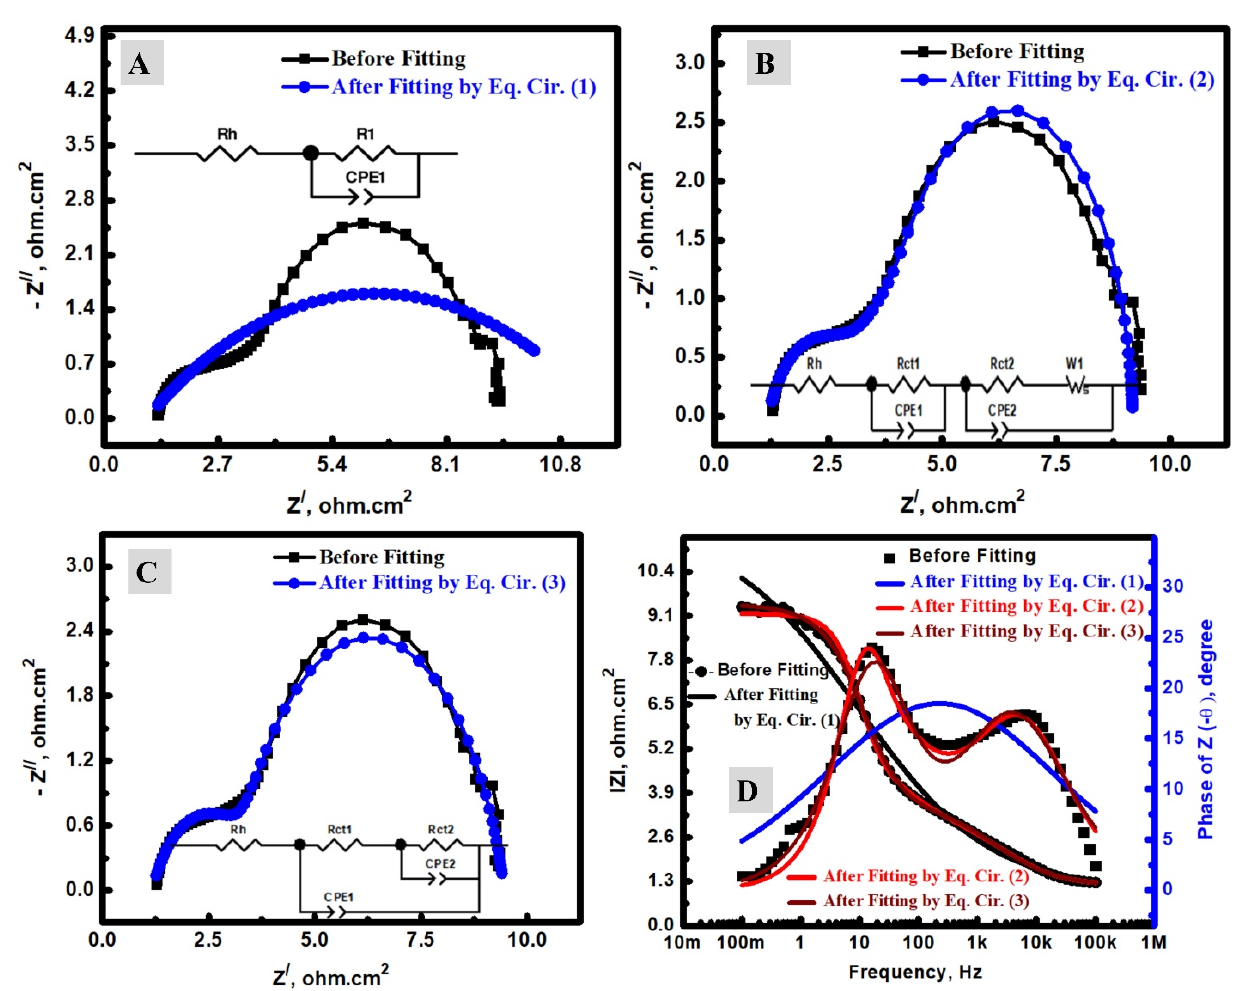
Figure 7. EIS analyses of DSCs using the prepared N-TiO 2 NFs, including experimental data and their fitting by ( A ) EQ1; ( B ) EQ2; ( C ) EQ3; ( D ) total impedance and bode phase data before and after equivalent circuit fitting.